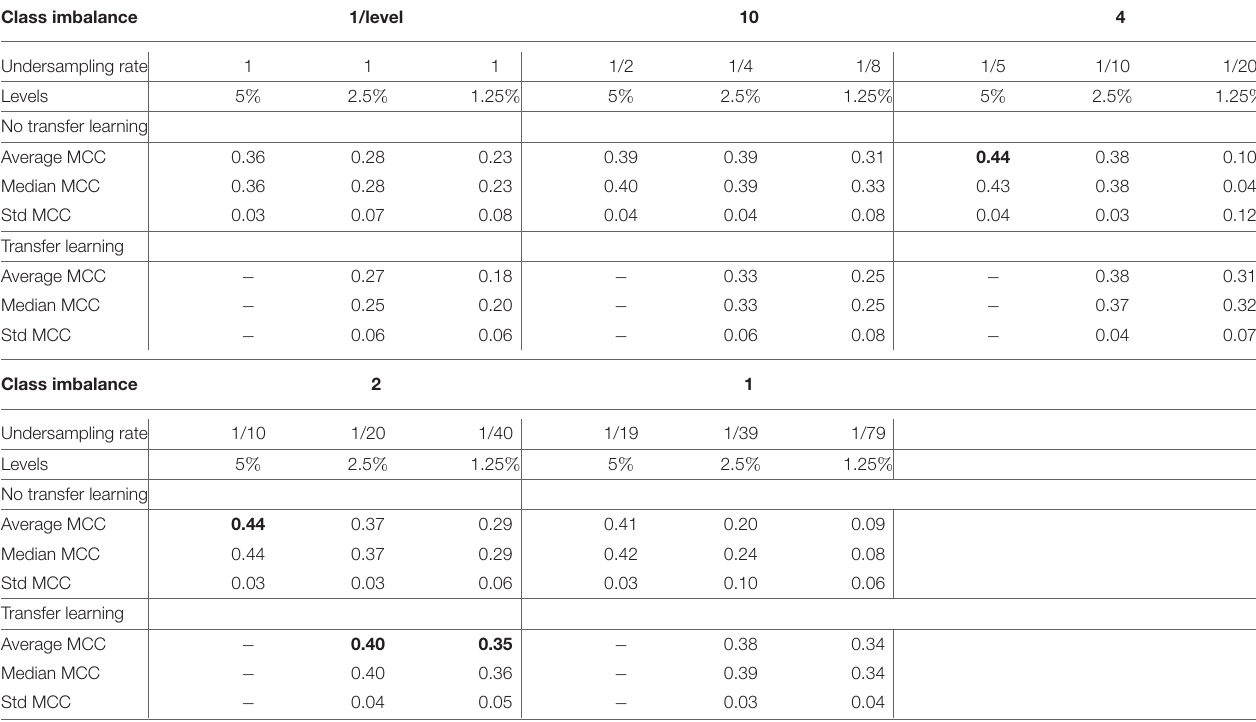
TABLE 3 | Compared performance for heatwave occurrence prediction with different undersampling rates. Class